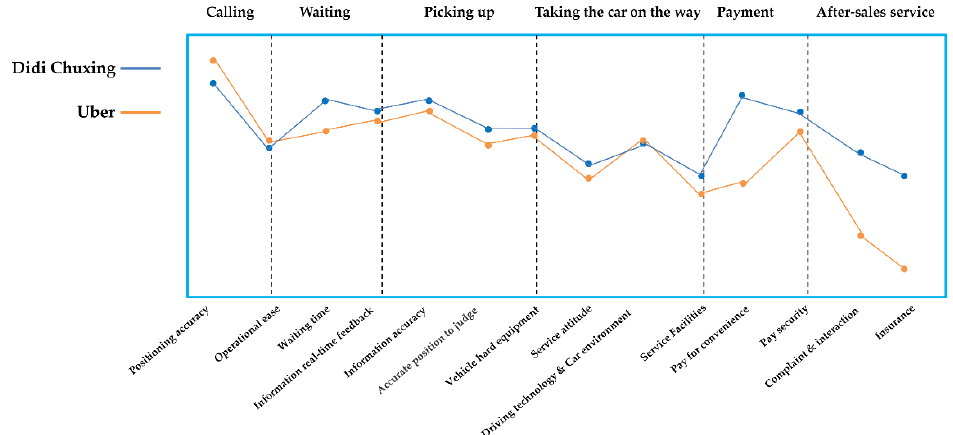
Figure 6. Value curve comparisons between DiDi and